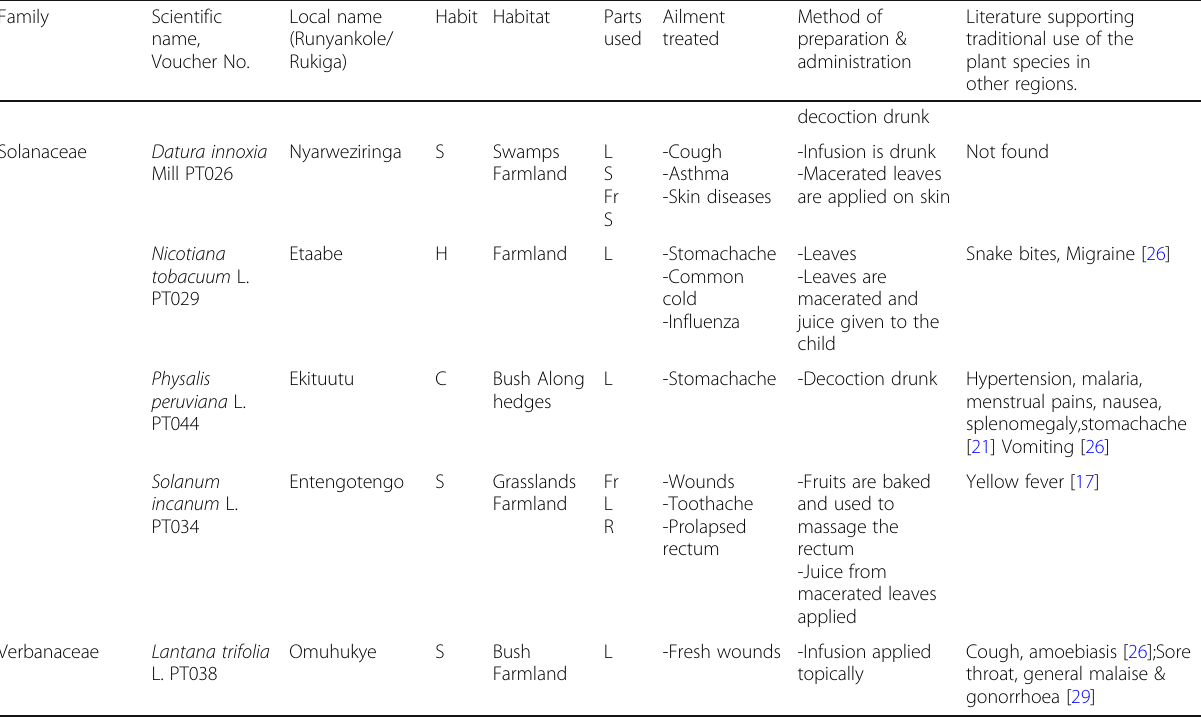
Key: Habit: H – Herb, S – Shrub, T – Tree, C – Climber, Parts used: L – Leaves, R- Roots, Fr – Fruits, S- Seeds, Wp – Whole plant, B – Bark,. Habitat means areas where respondents sourced the plant species; Farmland represents cultivated land, banana